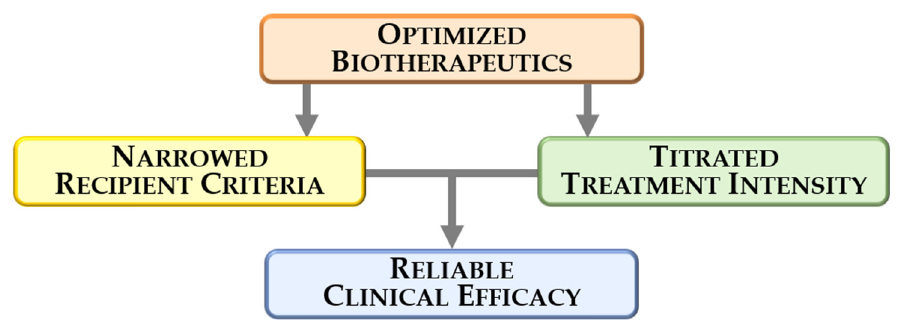
Figure 1. Contributors to the clinical benefit of a regenerative therapy include: (i) use of optimized biotherapeutics with predictable therapeutic potency pre-assessed prior to delivery; (ii) selection of candidates most likely to respond to therapy; and (iii) delivery of adequate treatment